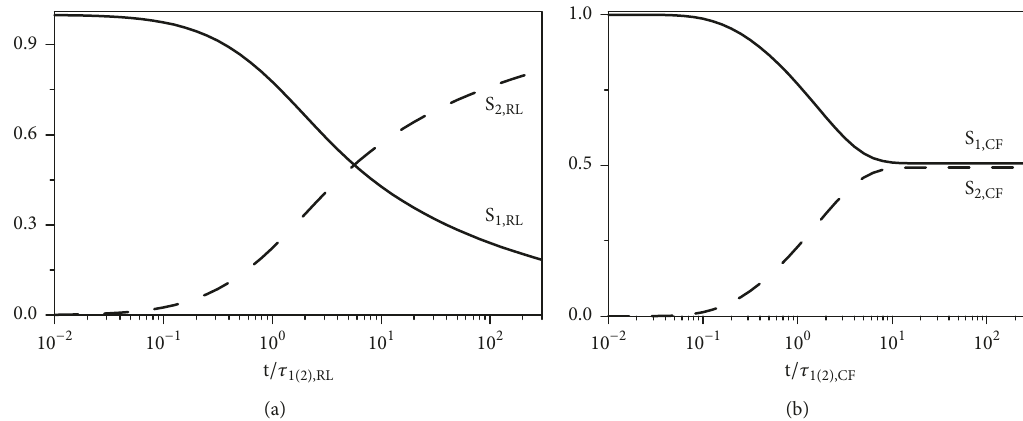
Figure7:(a)illustratesthesurvivalprobabilityforspecies 1 and 2 byconsideringtheRiemann-Liouvillefractionaltimeoperator.Weconsider, for simplicity, 𝜏 1(2),𝑅𝐿 = (𝑥 󸀠2 / K 1(2) ) 1/𝛼 1(2) , 𝑘𝜏 1(2),𝑅𝐿 /𝑥 󸀠 = 1 , 𝜑 1 (𝑥) = 𝛿(𝑥 − 𝑥 󸀠 ) , 𝜑 2 (𝑥) = 0 , and 𝛼 (1)2 = 1/2 , in arbitrary unities. (b) illustrates the survival probability for species 1 and 2 by considering the Caputo-Fabrizio fractional time operator. We consider, for simplicity, 𝜏 1(2),𝐶𝐹 = 𝑘𝜏 /𝑥 󸀠 = 1 , 𝜏 = 1 , 𝜑 (𝑥) = 𝛿(𝑥 − 𝑥 󸀠 ) , 𝜑 (𝑥) = 0 , and 𝛼 = 1/2 , in arbitrary unities. √ 𝑥 󸀠2 /𝐷 1(2) , 1(2),𝐶𝐹 1(2),𝐶𝐹 1 2 1(2)